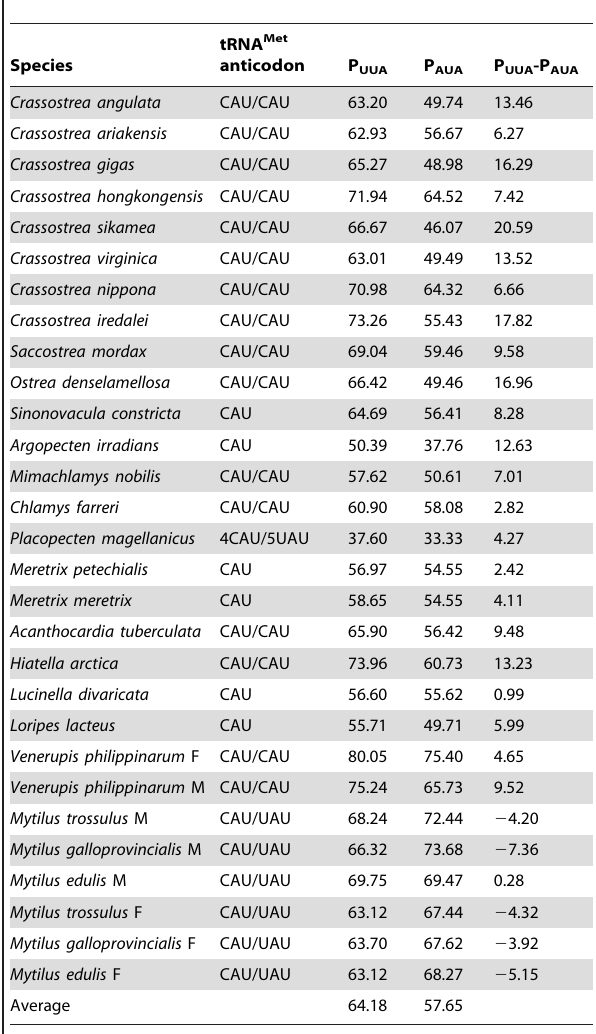
Table 2. The effect of anticodons of tRNA Met in 29 marine bivalve mitogenomes on P UUA and P AUA